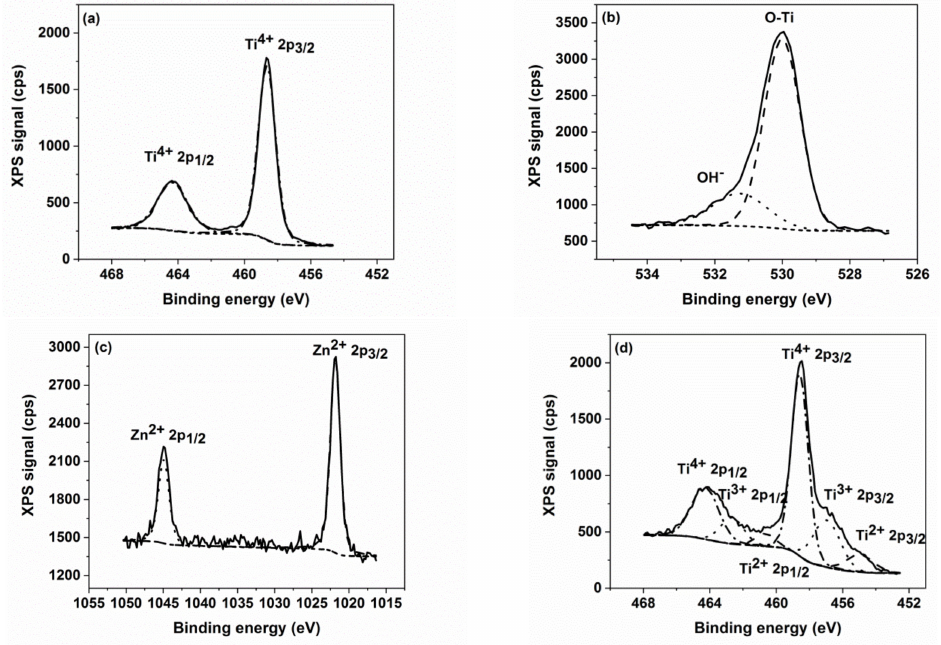
Figure 4. High-resolution XPS spectra of: ( a ) Ti 2p and ( b ) O 1s of the as-prepared layers; the spectra of Zn 2p and Ti 2p of the sputtered samples are depicted in panes ( c ) and ( d ),